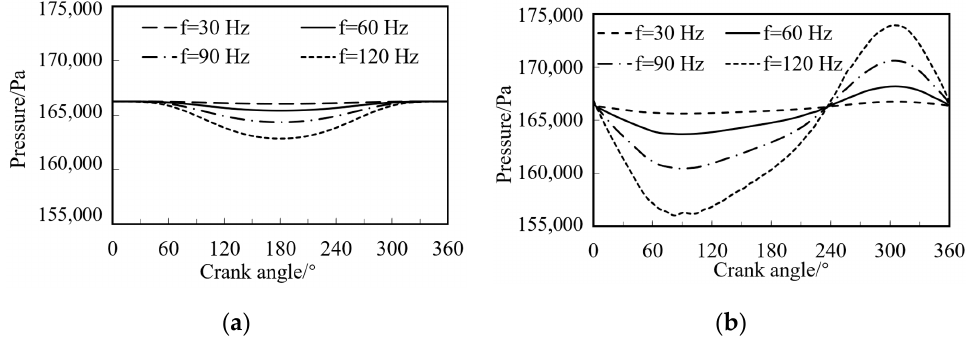
Figure 16. Pressure fluctuation of the accumulator. ( a ) inlet of the accumulator. ( b ) outlet of the accumulator.